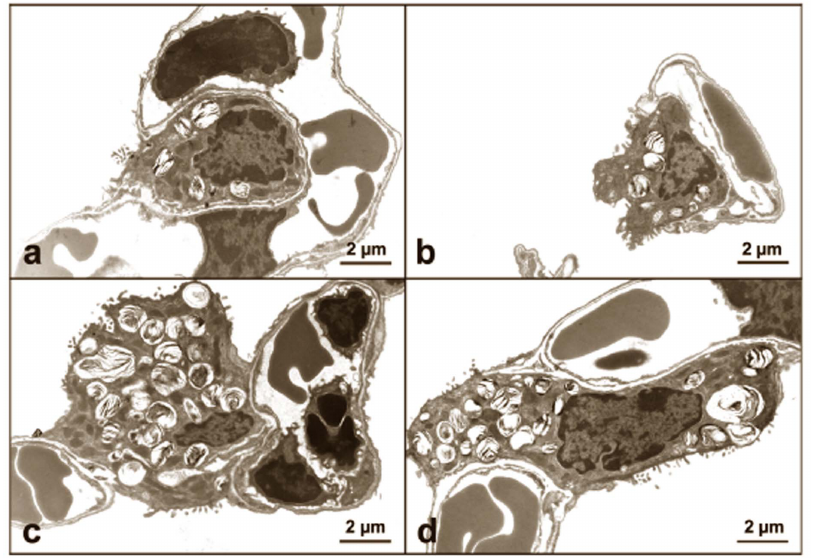
Figure 3. Lungs of DiNOS and Sftpd 2 / 2 mice exhibit AE2 hyperplasia and hypertrophy with increased numbers of lamellar bodies. Representative electron micrographs of AE2 cells of WT ( a ), NOS2 2 / 2 ( b ), Sftpd 2 / 2 ( c ) and DiNOS ( d ) mice. The profiles of AE2 cells in Sftpd 2 / 2 and DiNOS are bigger and seem to contain more lamellar bodies compared to WT and iNOS 2 / 2 mice.